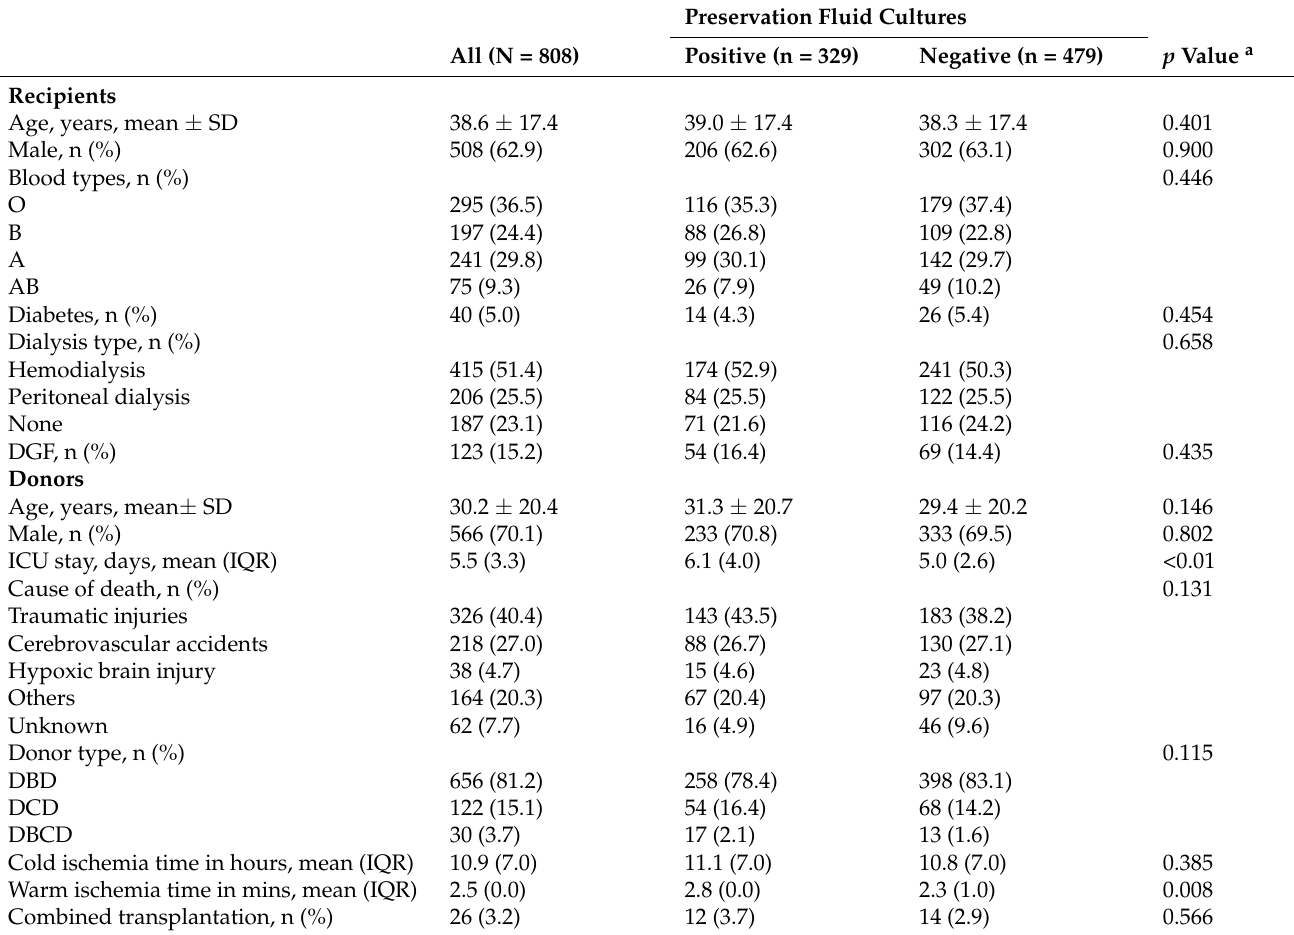
Table 1. Donor and recipient